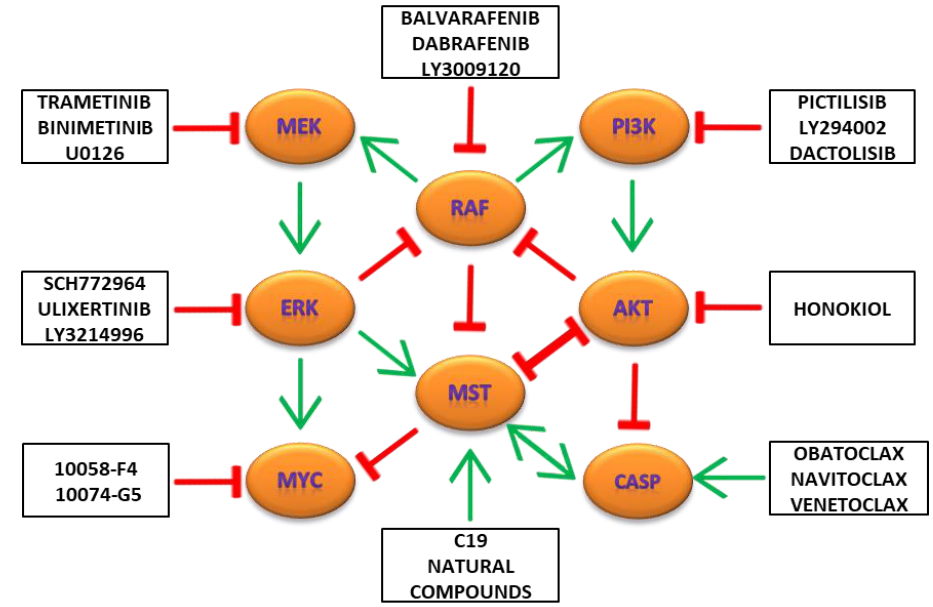
Figure 4. Targeting of the MAPK/ERK-Hippo/MST-PI3K/AKT network for effective cancer therapy.